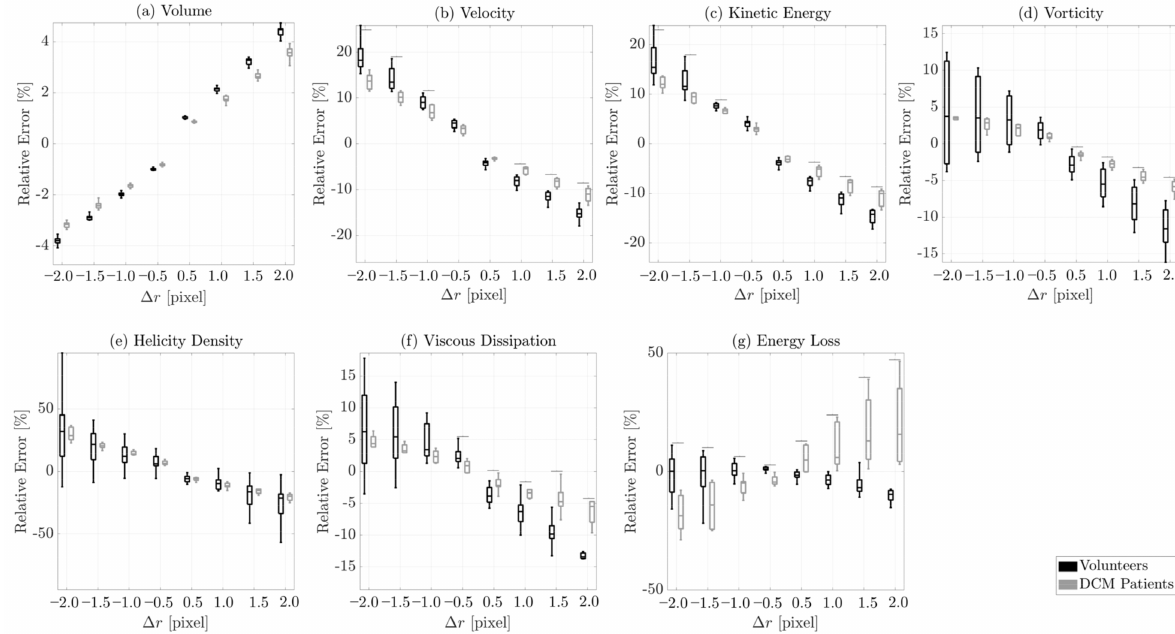
Figure 4. Relative error values of the volume ( a ) and each hemodynamic parameter ( b – g ) obtained comparing the reference segmentation with segmentations given by erosion or dilatation for each group of volunteers and patients at peak systole. * indicates statistically significant differences ( p < 0.05).